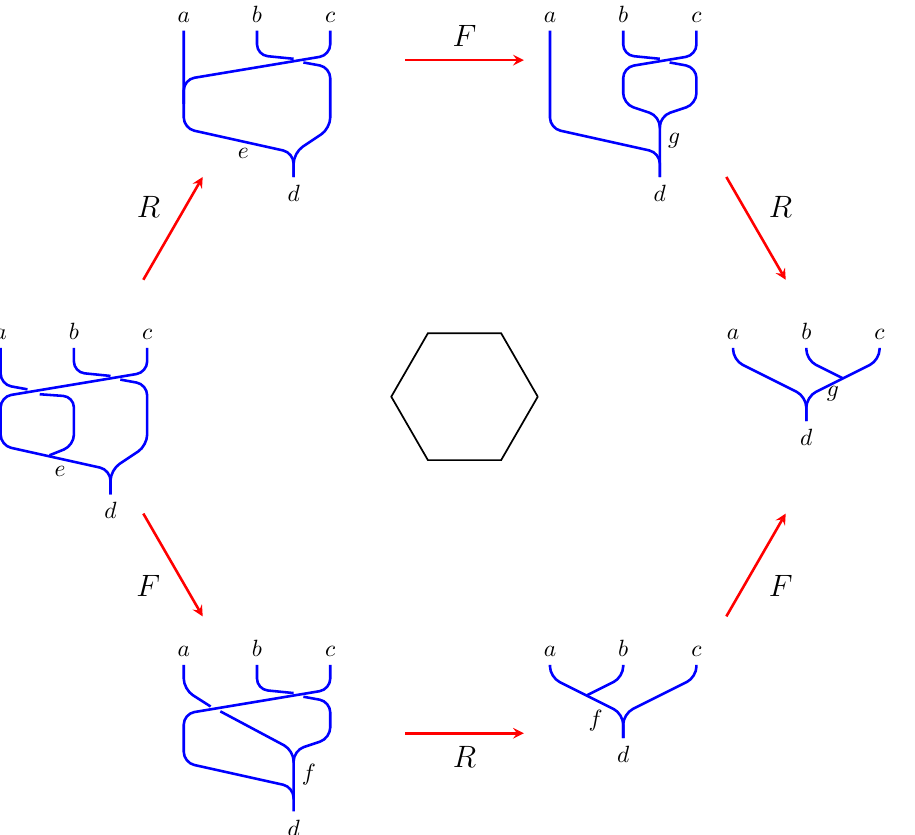
Figure 4 . The compatibility between the F - and R -matrices is encoded in the diagram above, in which one can go from left to right along the upper or lower path. The equivalence of the two procedures leads to the hexagon identity